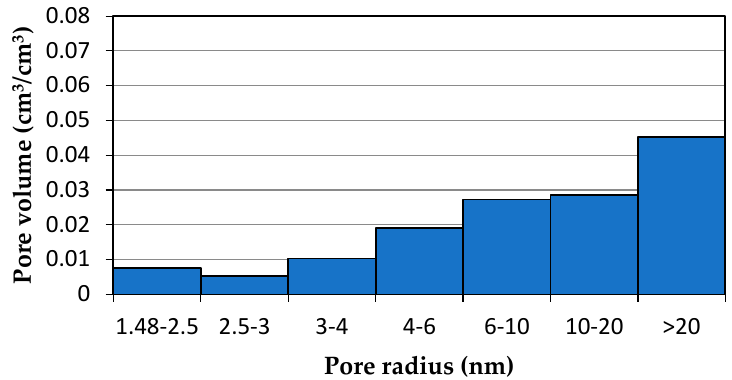
Figure 15. Pore size distribution that was obtained by thermoporometry from the phase transition energy distribution with the use of the modified algorithm. Running the proposed algorithm on the obtained phase transition energies was paramount to correctly determine the pore size distribution and, consequently, to predict the durability of materials. This knowledge provides an explanation of material properties, including the amount of capillary water in a unit of time, strength, and resistance to an aggressive environment.